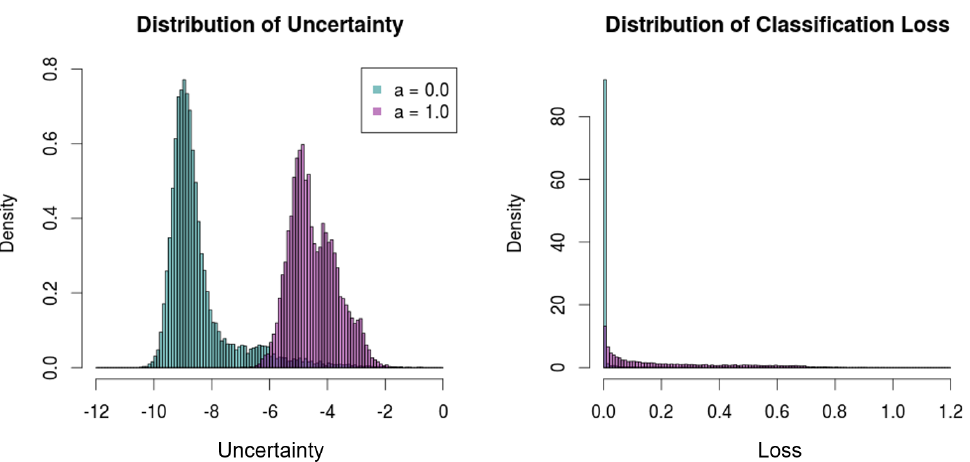
Figure 7. Distributions of the uncertainty and the classification loss with the test set ( a = 0.0) and noises ( a =